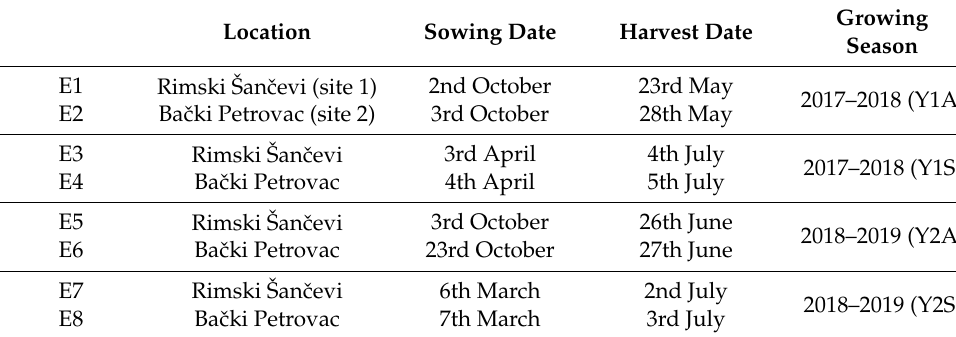
Table 3. Environments evaluated in the field